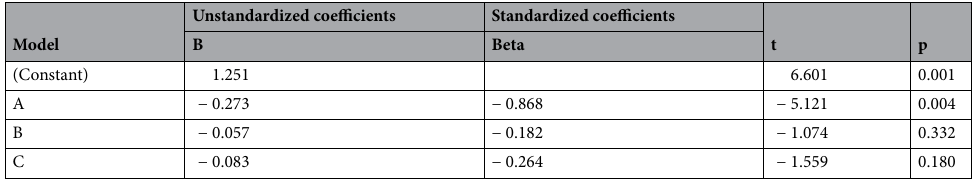
Table 5. The coefficient of linear regression. A represents the storage time of fresh whole blood at room temperature; B represents the storage time of RNA at room temperature; C represents the storage time of cDNA at − 20 °C.